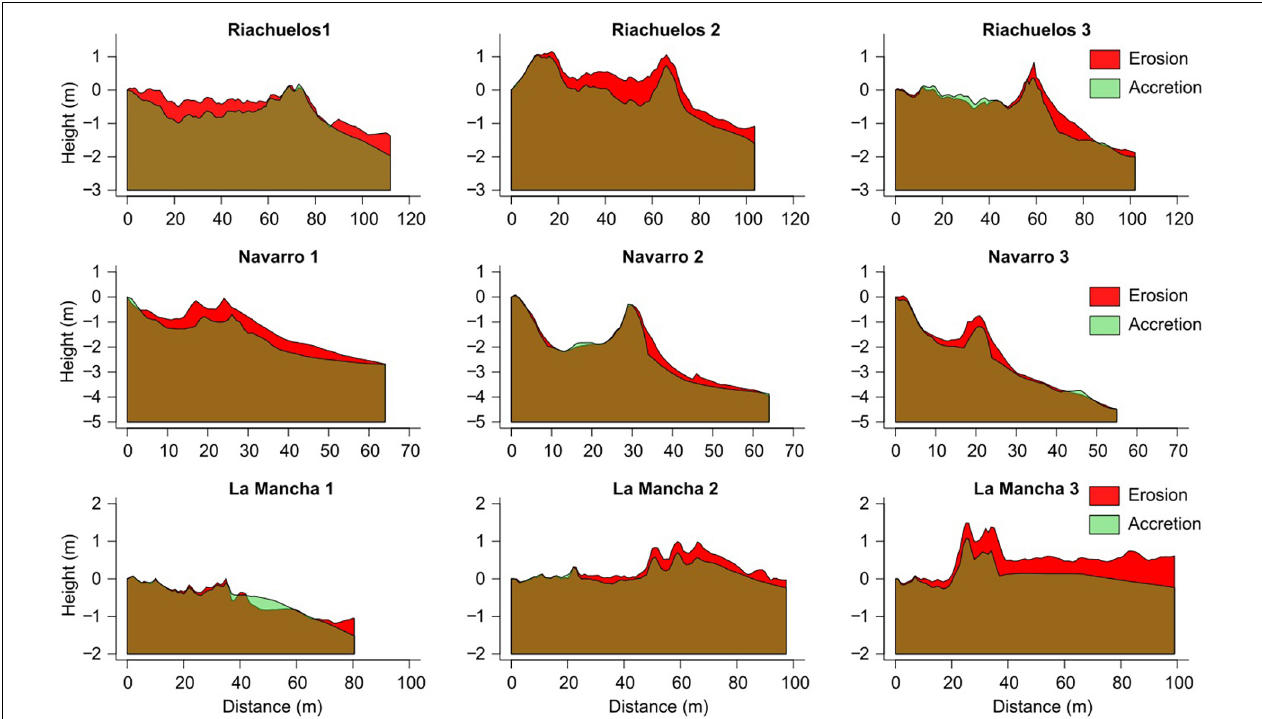
FIGURE 7 | Pre-and post-storm profiles on Riachuelos, Navarro, and La Mancha. Note that scale in axes y and x is not the same for all the beaches because of the differences in length and height of the beach and dune systems.